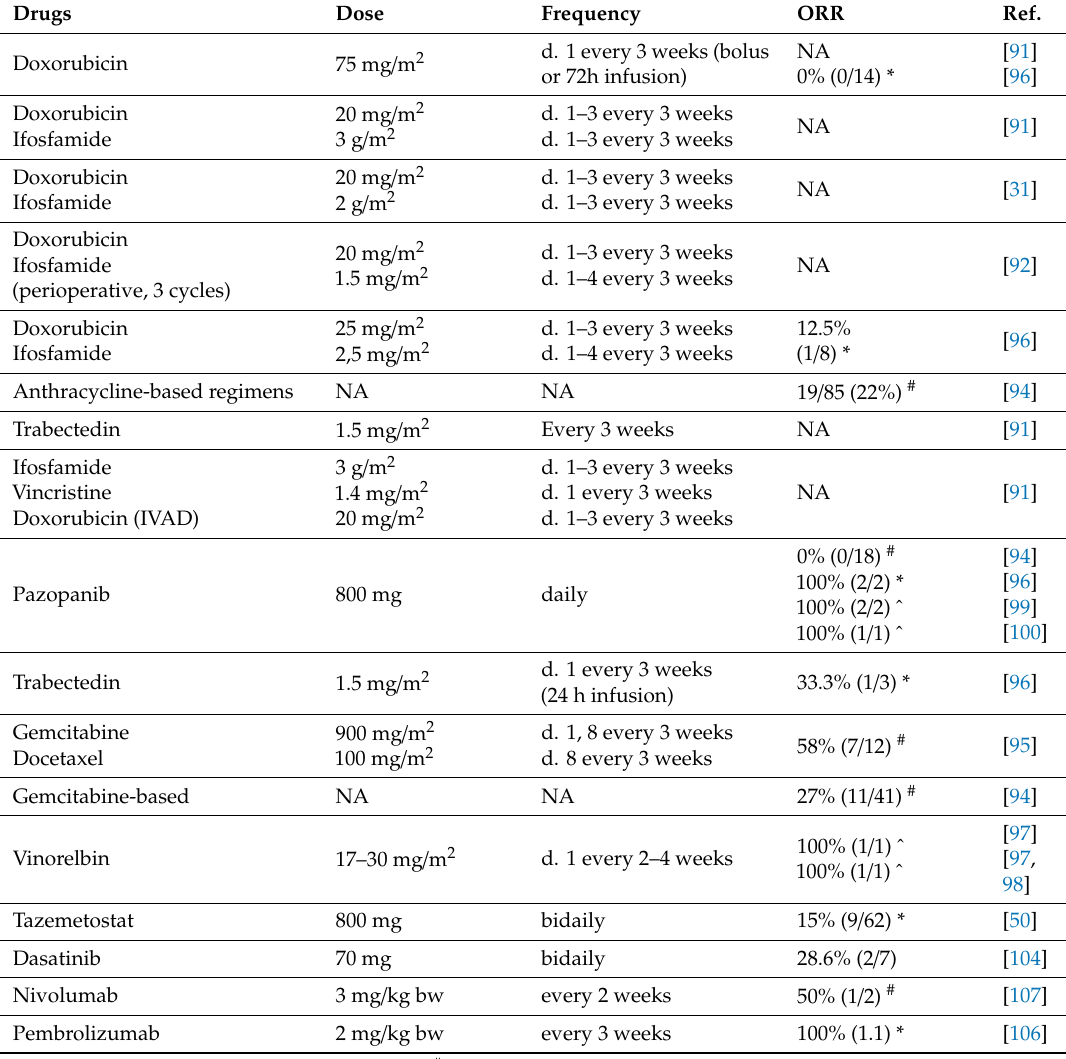
Table 1. Systemic therapy regimens available for epithelioid sarcoma treatment.